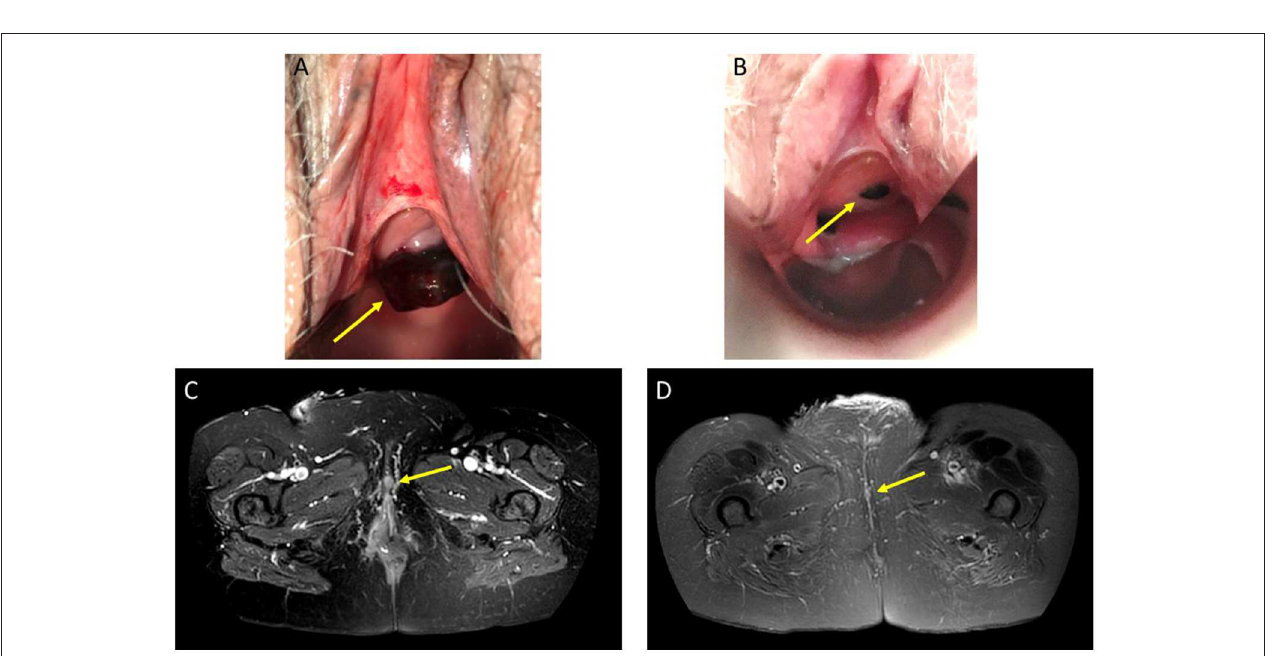
FIGURE 1 | Representative histopathologic images of the ulcerated primary pigmented mucosal melanoma of the Urethra. (A) Overview image of the histopathologic sample, H&E stained in 2,5-fold magnification. (B) Detailed view, H&E stained in 10-fold magnification.